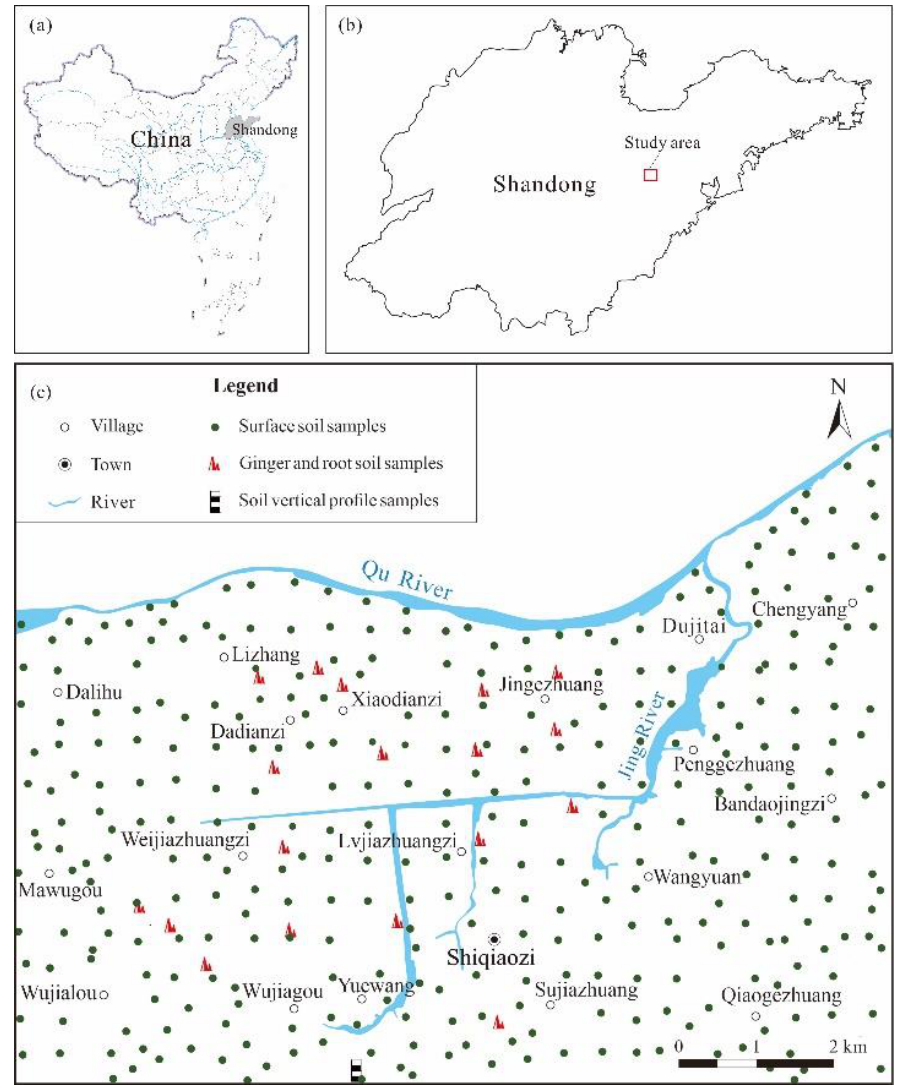
Figure 1. Location map of the study area ( a ) Location of Shandong Province ( b ) Location of the study area ( c ) Sampling location.